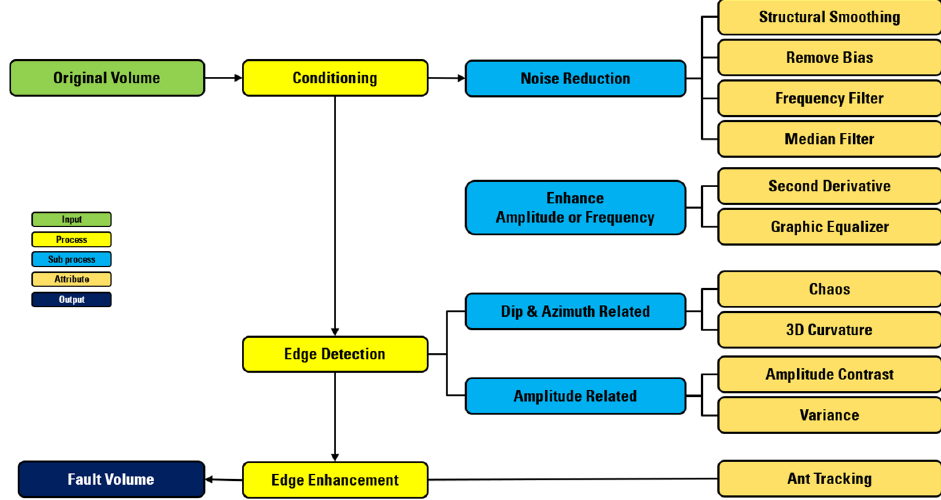
Figure 1. The conventional workflow for fault detection consists of conditioning, edge detection, and edge enhancement. It is set up to perform a significant number of sub-processes within each attribute.